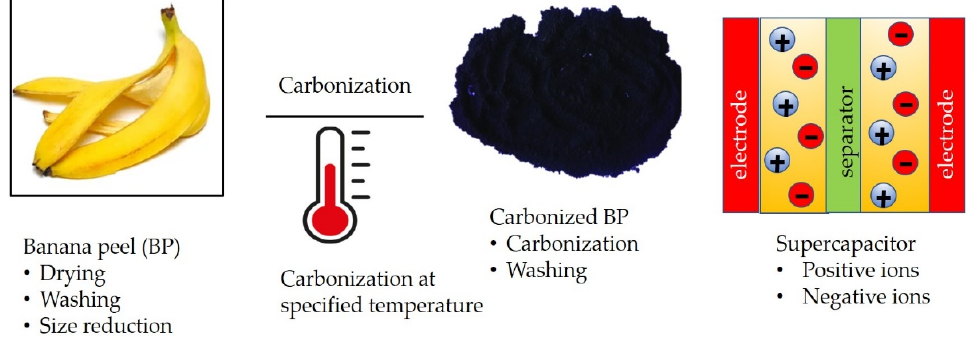
Figure 2. Illustrations showing process of manufacturing flexible supercapacitors starting from raw material preparation, carbonization and supercapacitor assembly.